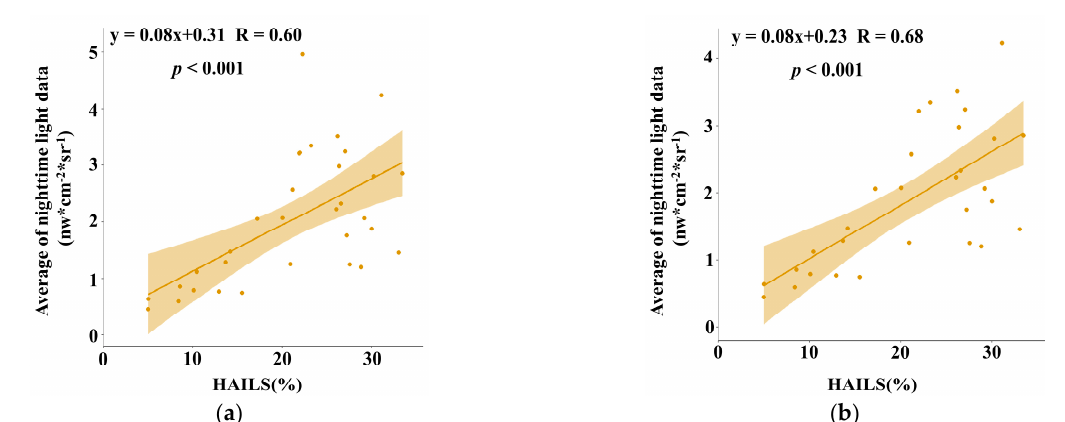
Figure 8. Correlation between average of nighttime light data and HAILS: ( a ) all 16 prefecture ‐ level cities; ( b ) 15 prefecture ‐ level cities without Hefei.